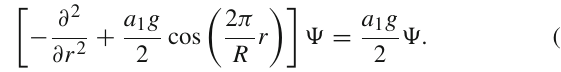
Fig. 13 Profiles for the gauged baryon solution n = 0 with vanishing boundary condition for (cid:16) at r = 0. The profile function F ( r ) is defined